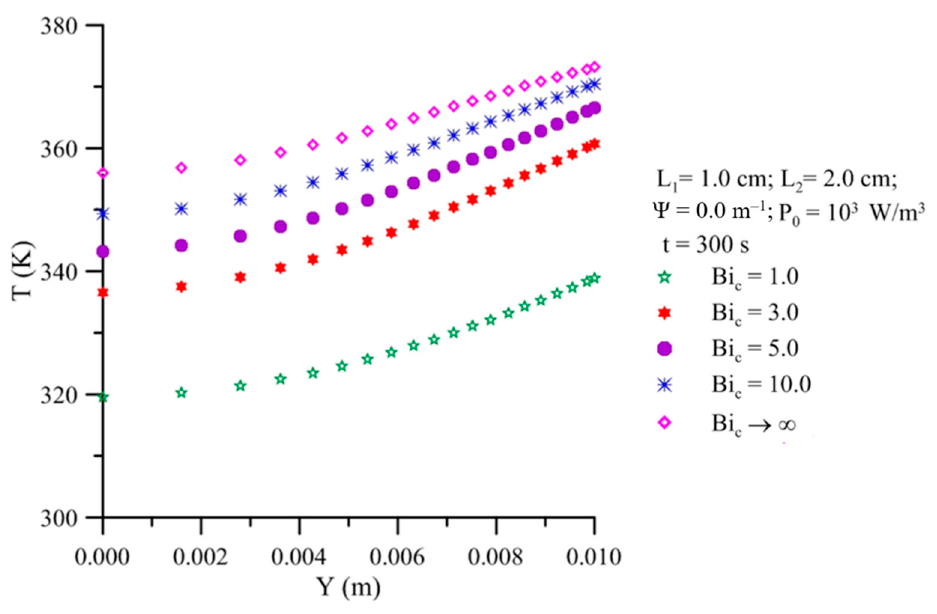
Figure 10. Temperature inside a prolate spheroidal solid with aspect ratio L 2 /L 1 = 2.0, different heat transfer Biot numbers and fixed microwave power density ( y -axis, z = 0, t = 300 s).